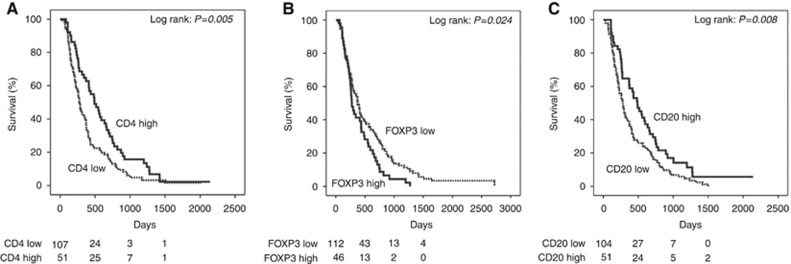
Kaplan–Meier survival curves of adaptive immune markers associated with survival in epithelioid mesothelioma. (A) Kaplan–Meier curves for epithelioid mesothelioma survival according to CD4+ T-cell counts (log-rank test, P=0.005). (B) Kaplan–Meier curves for epithelioid mesothelioma survival according to FOXP3+ T-regulatory cell counts (log-rank test, P=0.024). (C) Kaplan–Meier curves for epithelioid mesothelioma survival according to CD20+ B-cell counts (log-rank test, P=0.008).